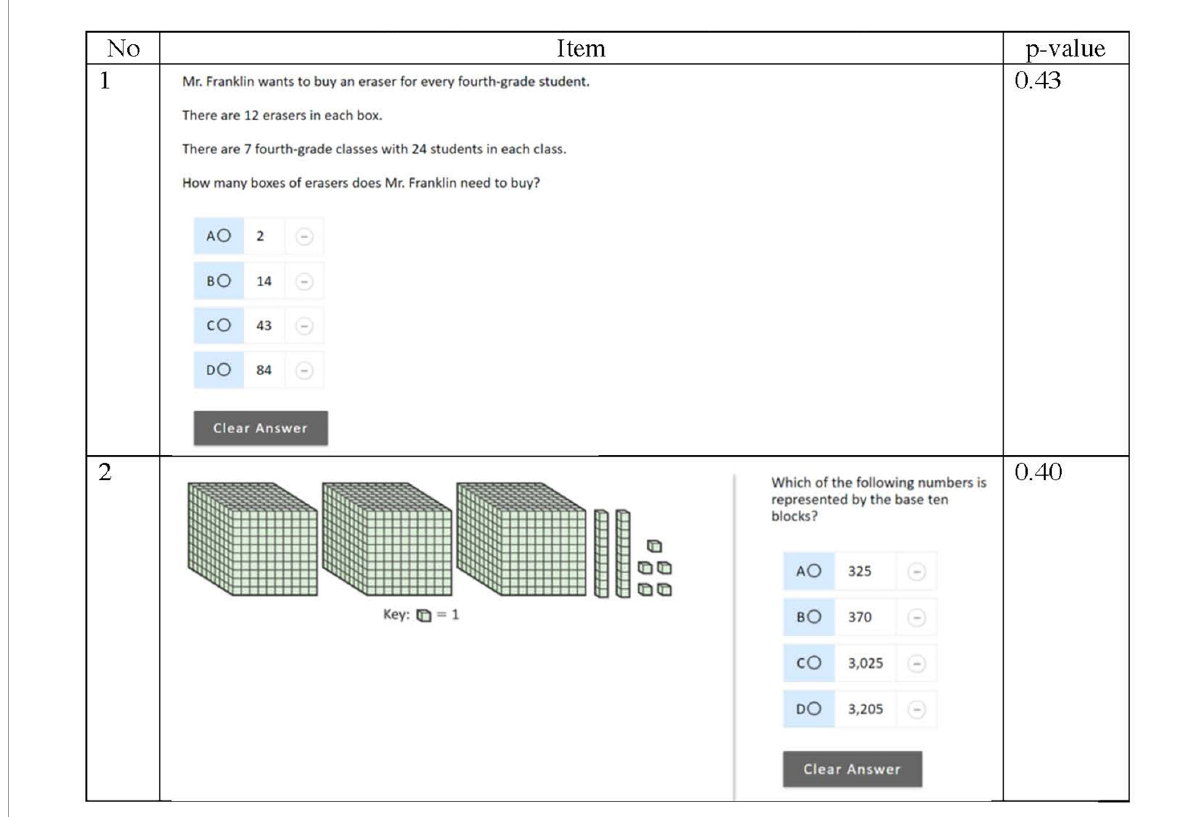
FIGURE1 NAEP items with similar difficulty assessing number properties and operations. Source: U.S. Department of Education, Institute of Education Sciences, National Center for Education Statistics, National Assessment of Educational Progress (NAEP), 2017 Mathematics Assessment.